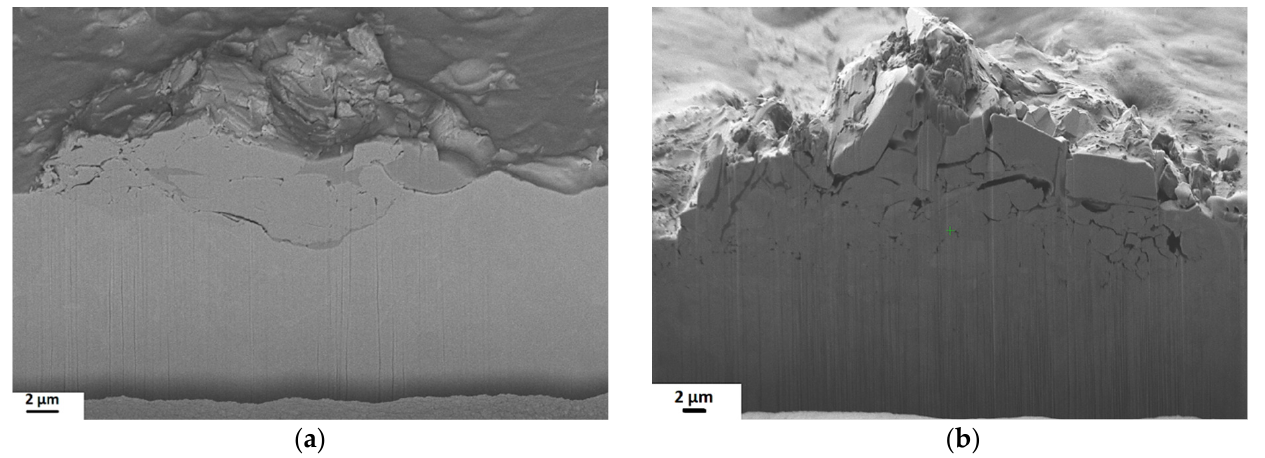
Figure 10. SEM images of Ti 3 AlC 2 sprayed particles at: ( a ) ~723 m/s; ( b ) ~780 m/s on TA6V.